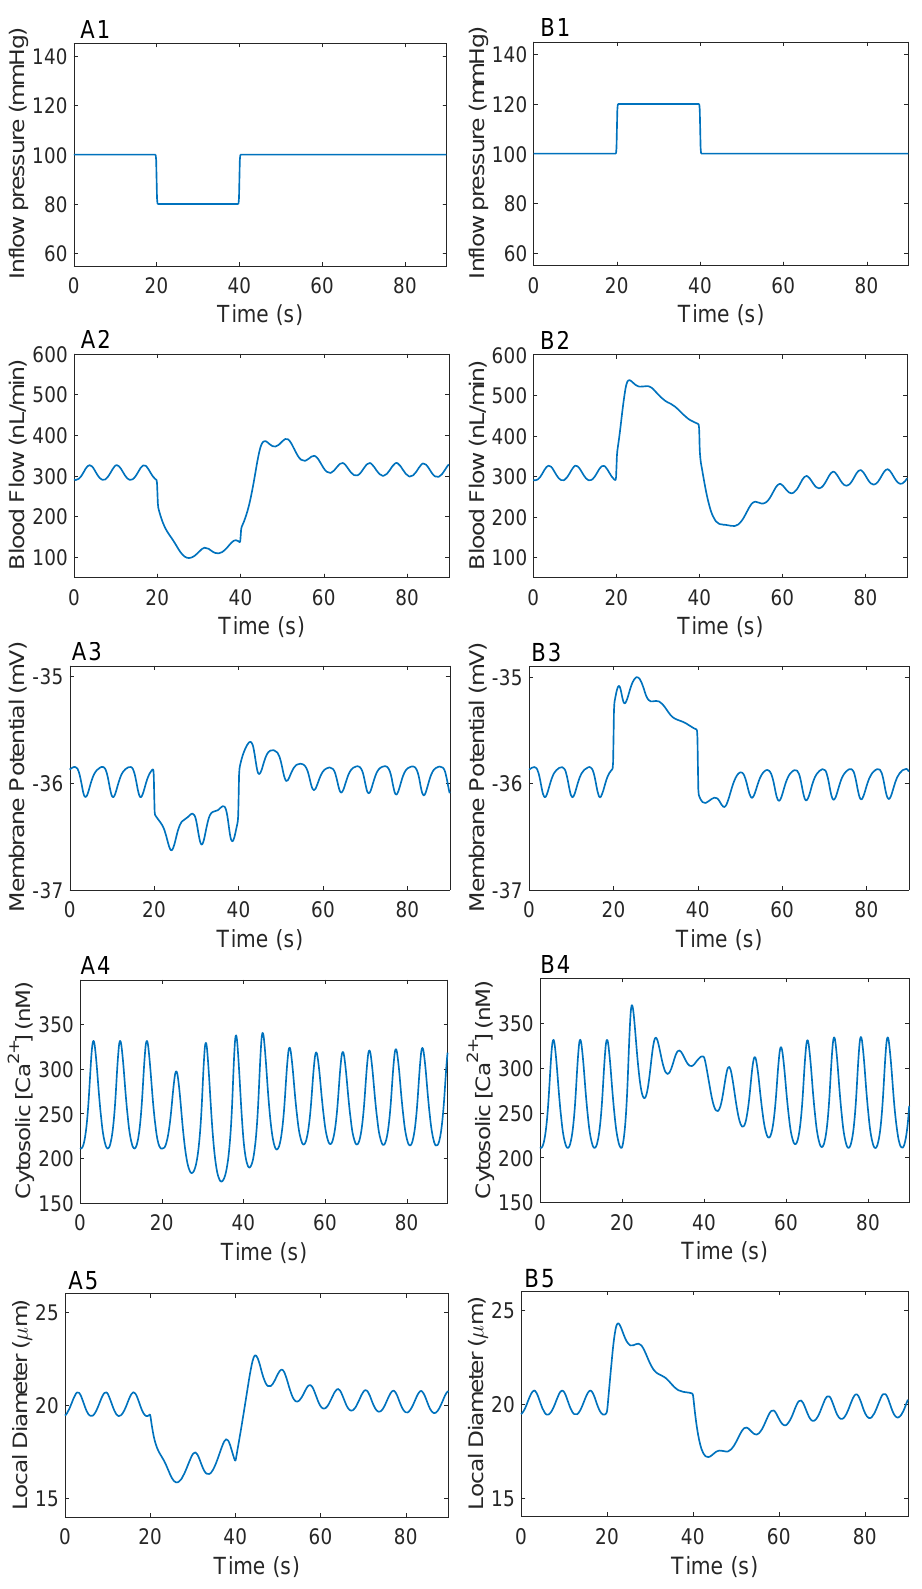
Figure 7. Predicted time profiles of ( 1 ) inflow pressure; ( 2 ) blood flow; ( 3 ) membrane potential; ( 4 ) cytosolic Ca 2 + concentration; and ( 5 ) local diameter for the first cell in the model afferent arteriole under ( A ) pressure pulse decrease to 80 mmHg; and ( B ) pressure pulse increase to 120